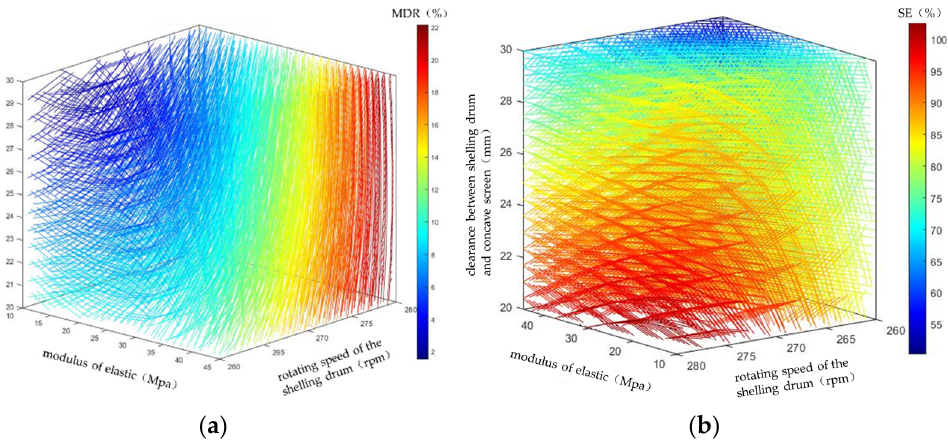
Figure 7. Four-dimensional slice diagrams of significant influencing factors on MDR ( a ) and SE ( b ).